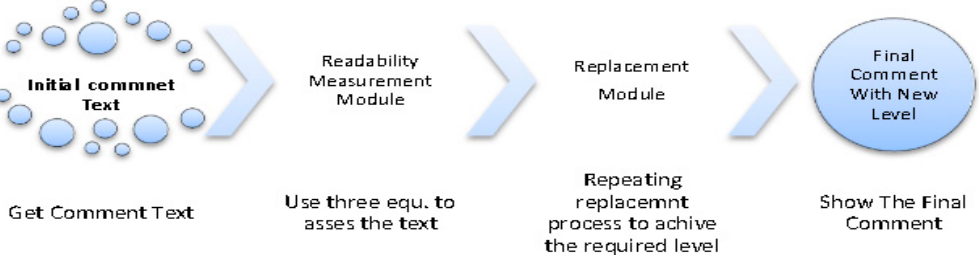
Figure 2. System general steps.